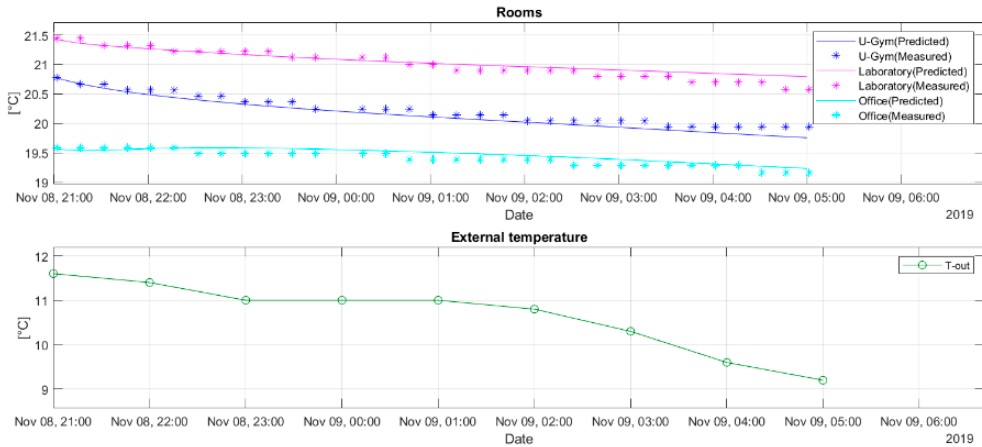
Figure 7. Nighttime room and external temperatures.